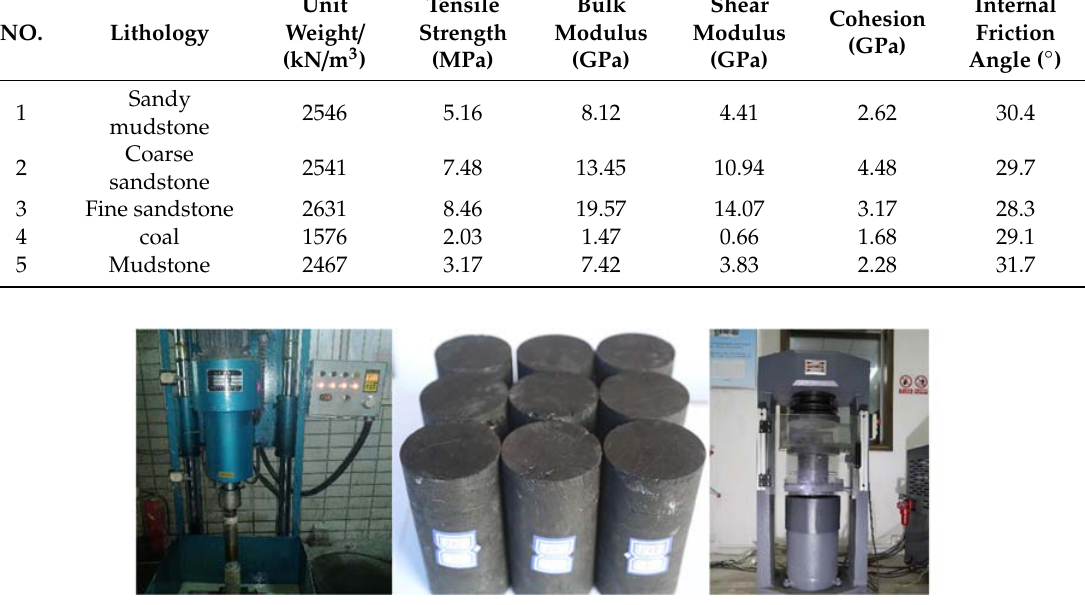
Figure 8. The mechanical test. Table 2. Mechanical parameters.